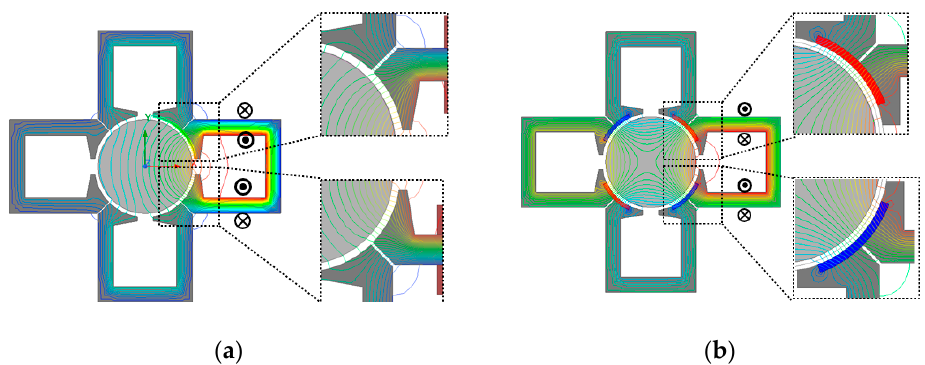
Figure 12. STMB and HSTMB’s magnetic flux line: ( a ) STMB magnetic flux line and ( b ) HSTMB magnetic flux line. Table 2. HSTMB specification.